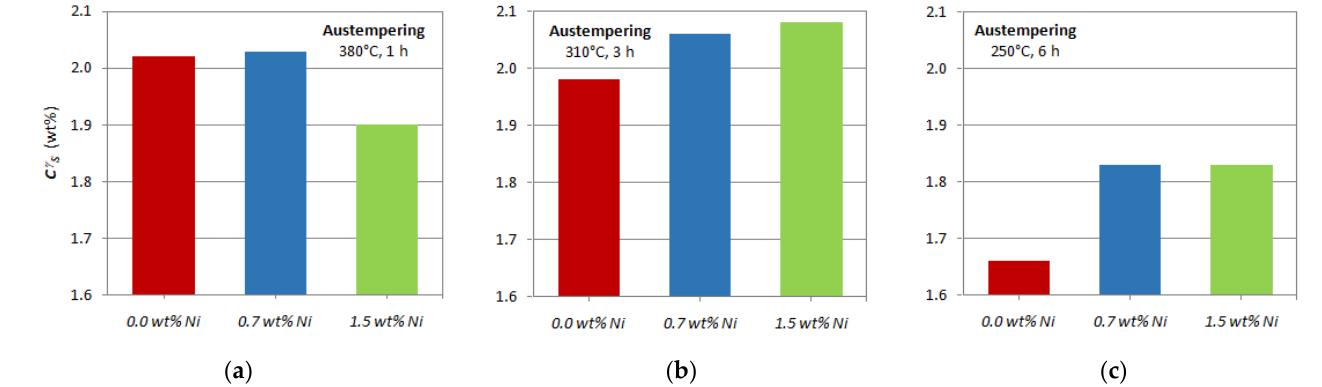
Figure 20. C content in austenite ( C γ S ) in 25 mm Y-block ADIs for different Ni contents and differ- ent austempering conditions: ( a ) 380 °C for 1 h; ( b ) 310 for 3 h; ( c ) 250 °C for 6 h. austempering conditions: ( a ) 380 ◦ C for 1 h; ( b ) 310 for 3 h; ( c ) 250 ◦ C for 6